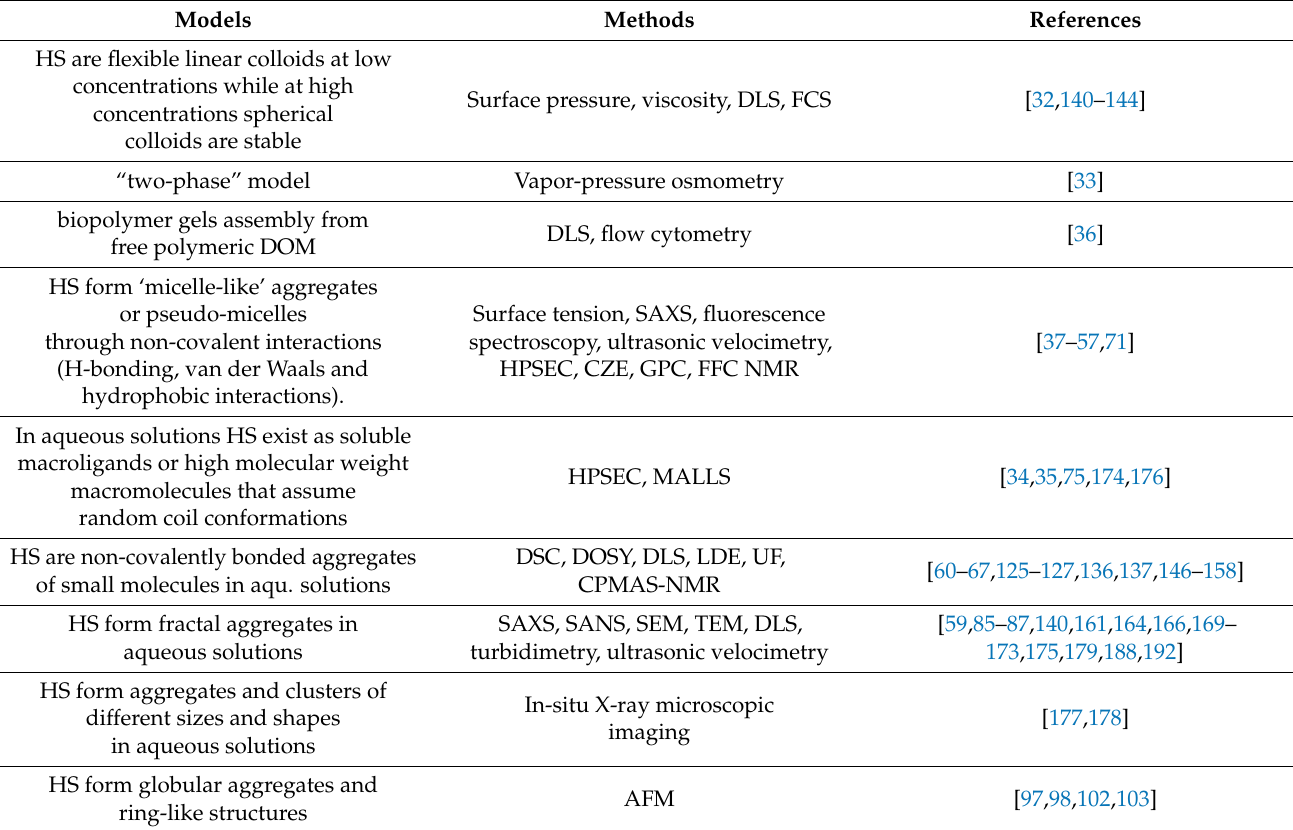
Table 1. Models on the structure of Humic Substances, experimental methods and cited